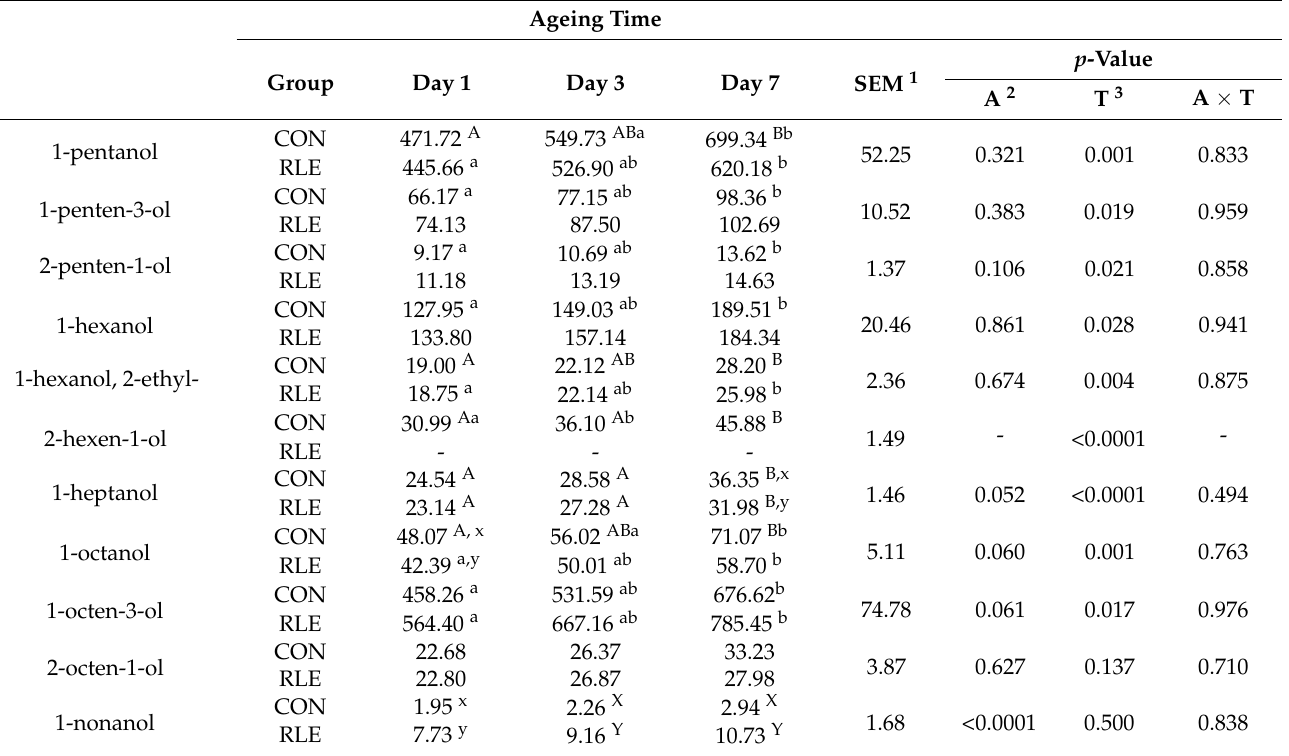
Table 5. Effects of anthocyanin diet addition and ageing on alcohol volatile compounds of meat from goat kids ( n = 30 samples for each experimental group). Results are expressed as ng/g of